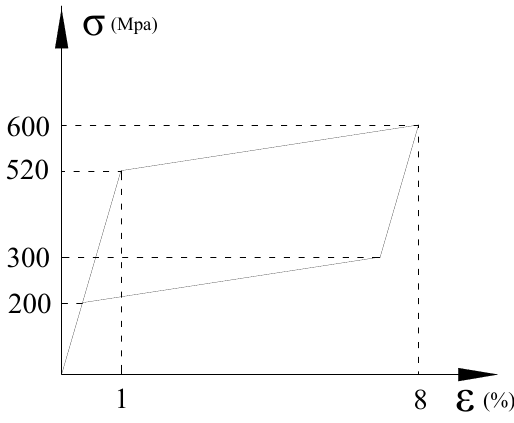
Figure 7. SMA cable stress and strain model.